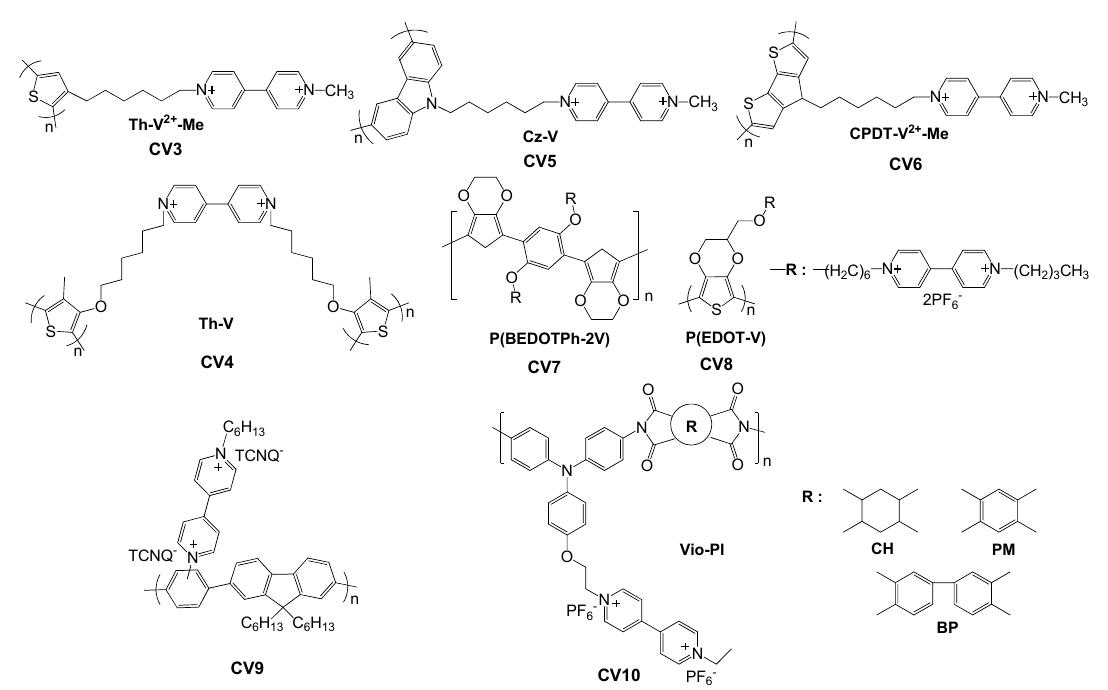
Figure 10. Conjugated polymers bearing viologen groups as pendant.